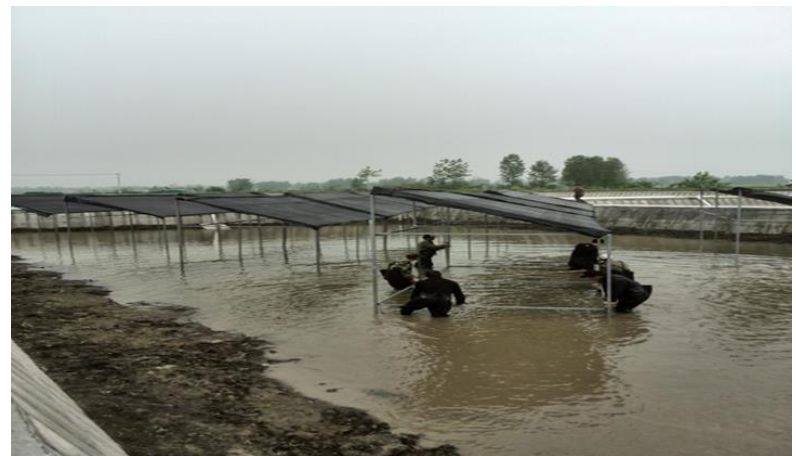
Figure 1. Install scene of photovoltaic shading simulation device.